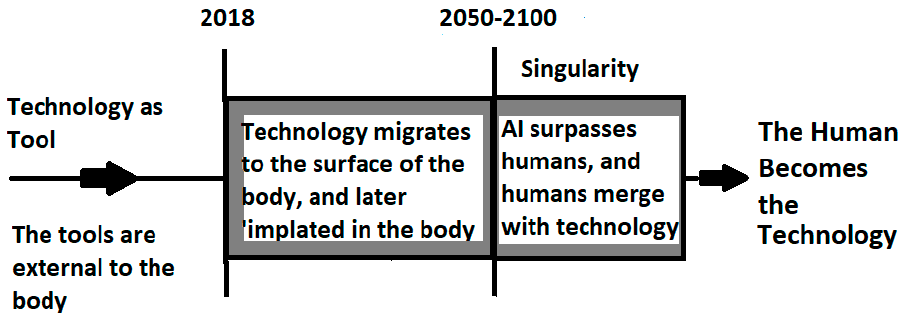
Figure 1. Timeframe for humans to merge with technology and for artificial intelligence to reach human levels of intelligence. 430